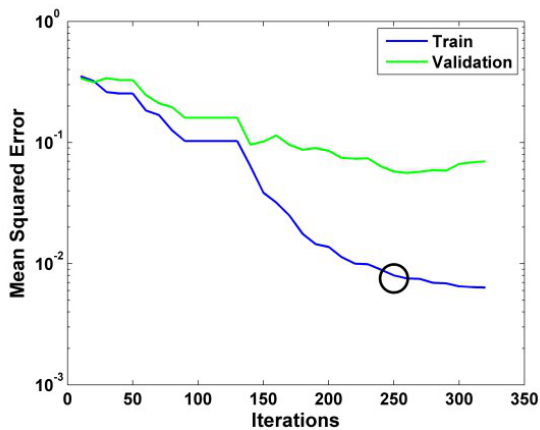
Table 8. Genetic Algorithm Parameters.